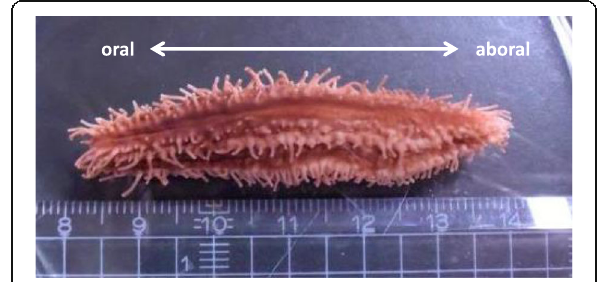
Fig. 1 The animal used in the study. A small sea cucumber, Eupentacta quinquesemita , is about 5 cm in size. The left side in this figure is oral (anterior), and the right side is aboral